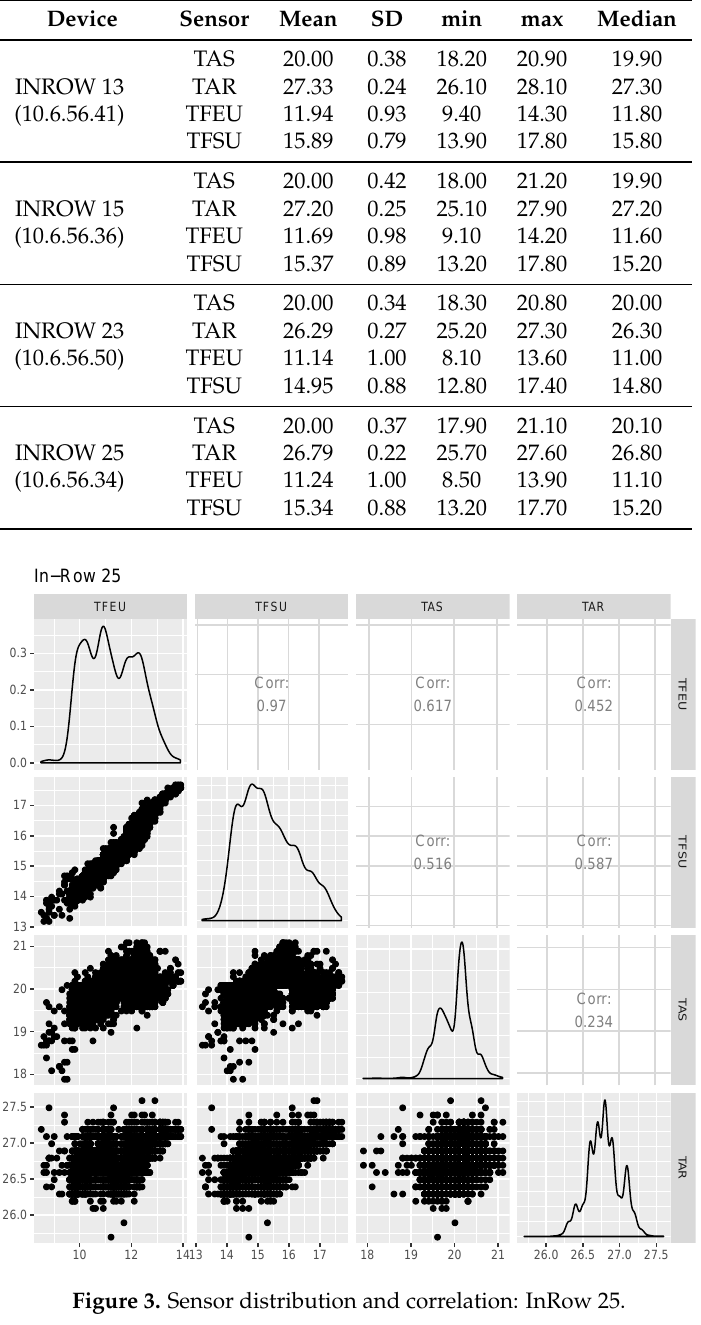
Figure 3. Sensor distribution and correlation: InRow